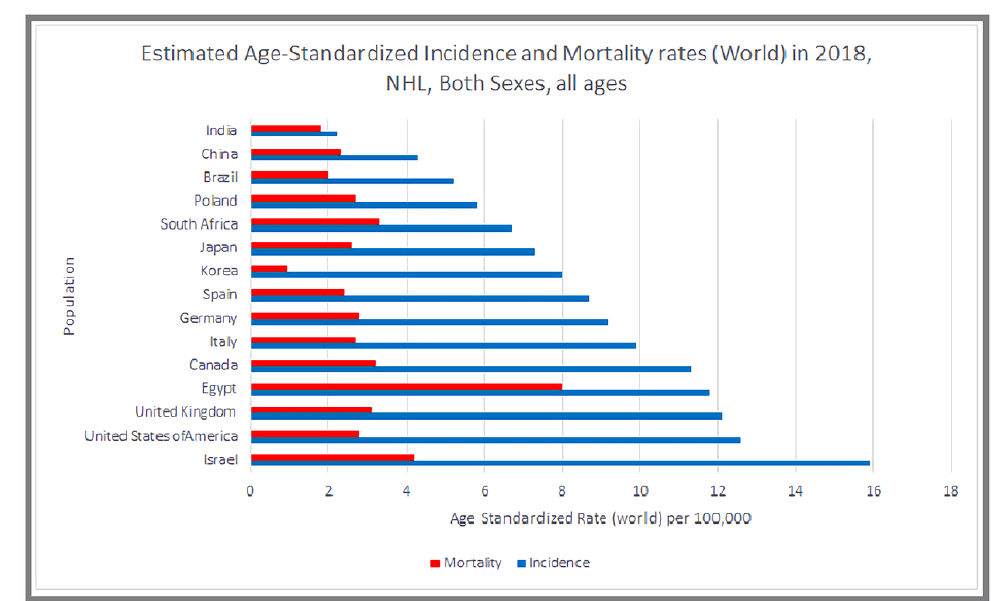
Figure 1. Bar chart showing estimated age-standardized incidence and mortality rates (World) in 2018, non-Hodgkin’s lymphoma, all sexes, all ages. Data obtained from Globocan